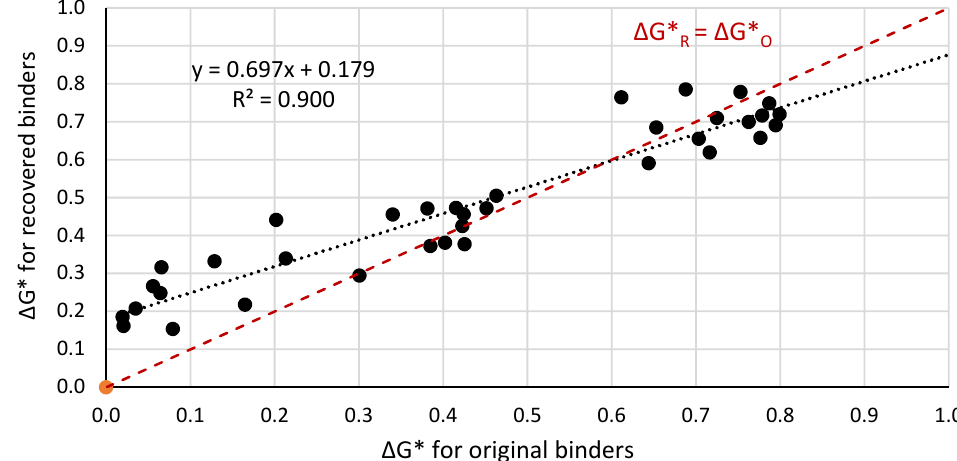
Figure 6. Correlation of the ∆ G* R index for extracted binders and ∆ G* O index for original binders in the temperature range from − 5 ◦ C to +100 ◦ C limited only to the group of paving